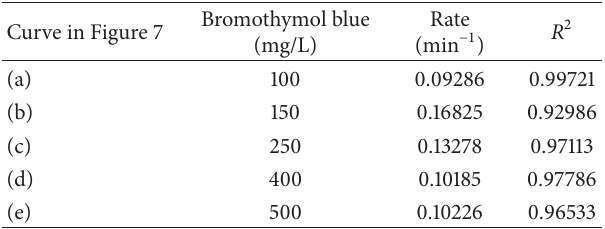
Table 2: Rates constants of degradation of bromothymol blue